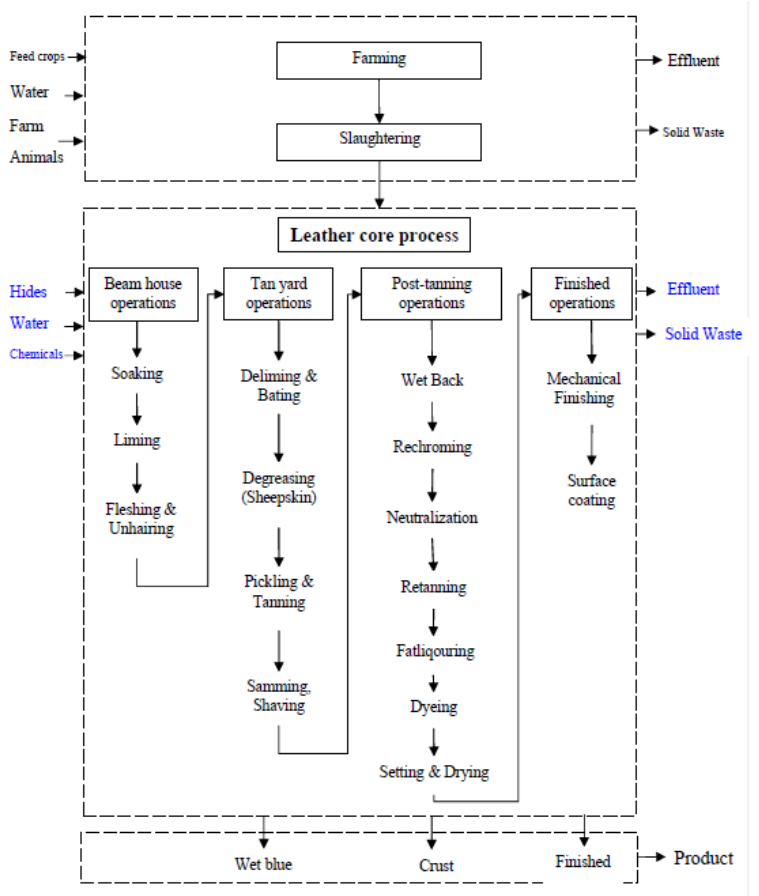
Figure 1. Overview of leather processing from feed crop cultivation to finished product.